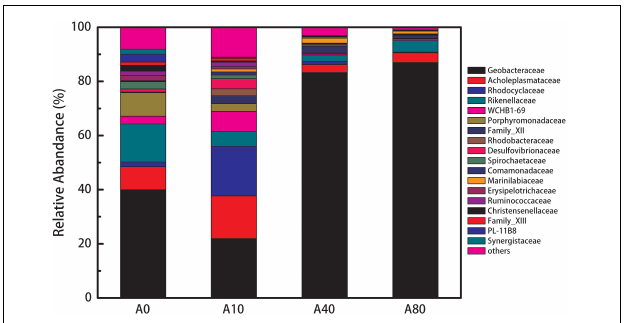
FIGURE 5 | Composition and relative abundance of bacteria in A0-80 at the family level. The bacteria shown in the legend was selected based on a relative abundance higher than 0.5% of total